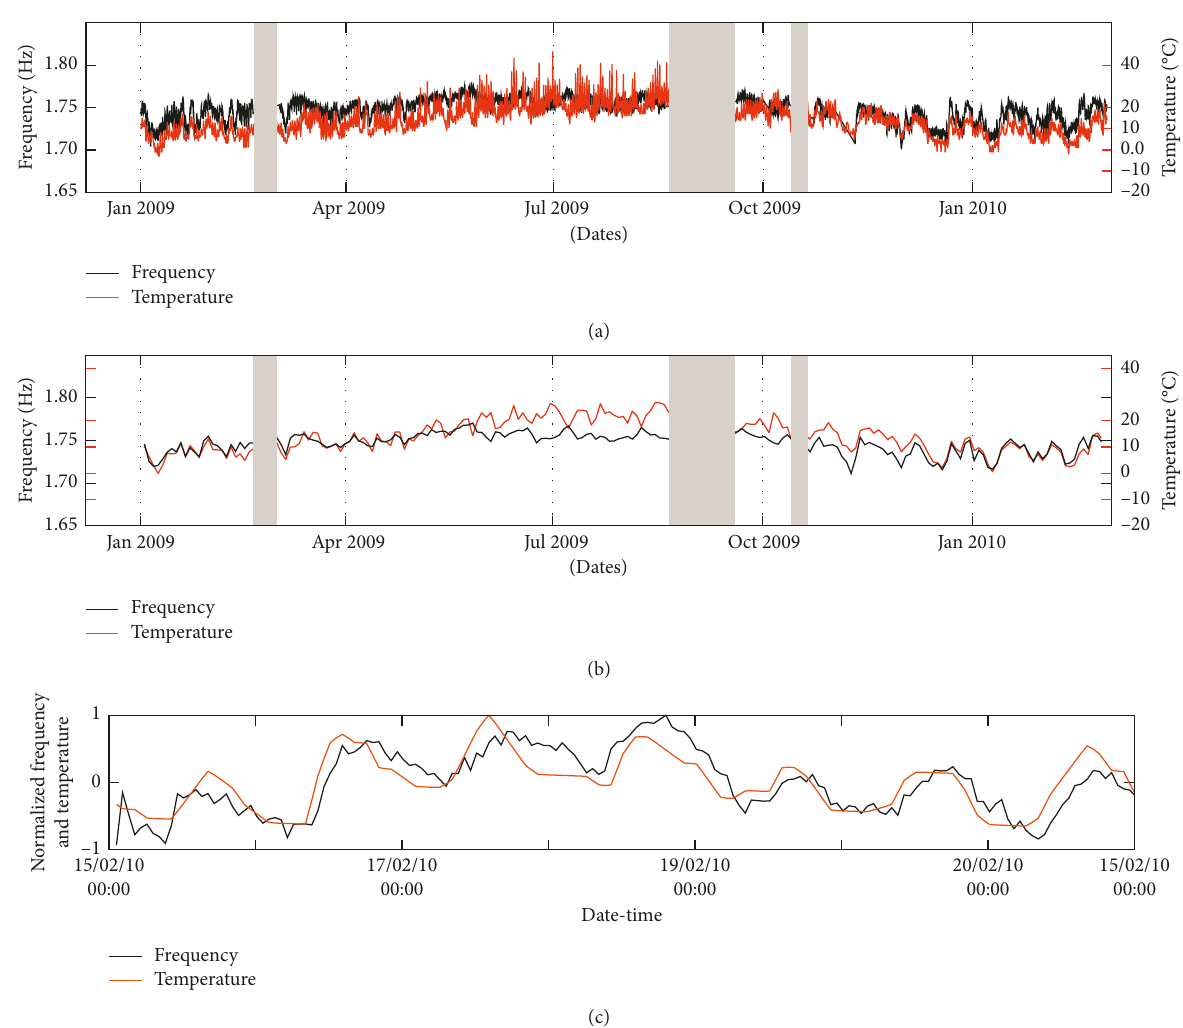
Figure 3: Frequency (black) and temperature (red) variations recorded at the OT. (a) Raw data, (b) seasonal variations after applying a low- pass filter (48 hours), and (c) daily variations over one week of frequency and temperature normalized to overlap the two curves. Gray zones correspond to a gap in the continuity of the